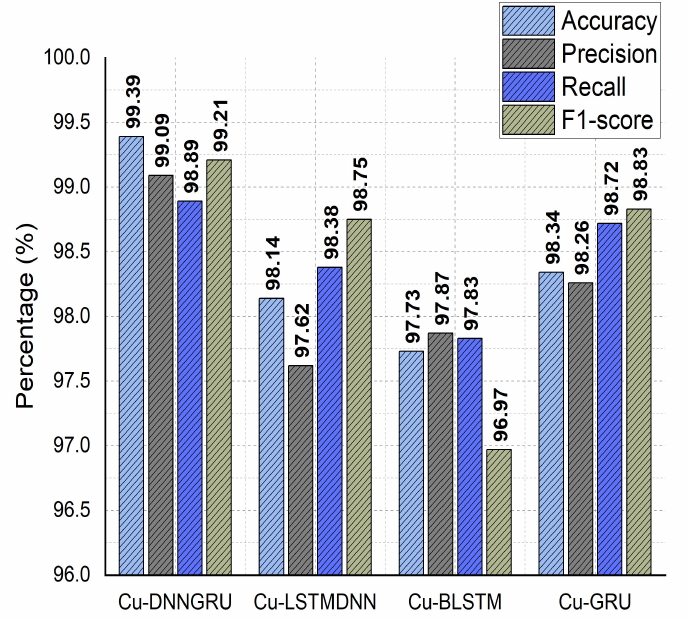
Figure 4. Accuracy, precision, recall, and F1-score